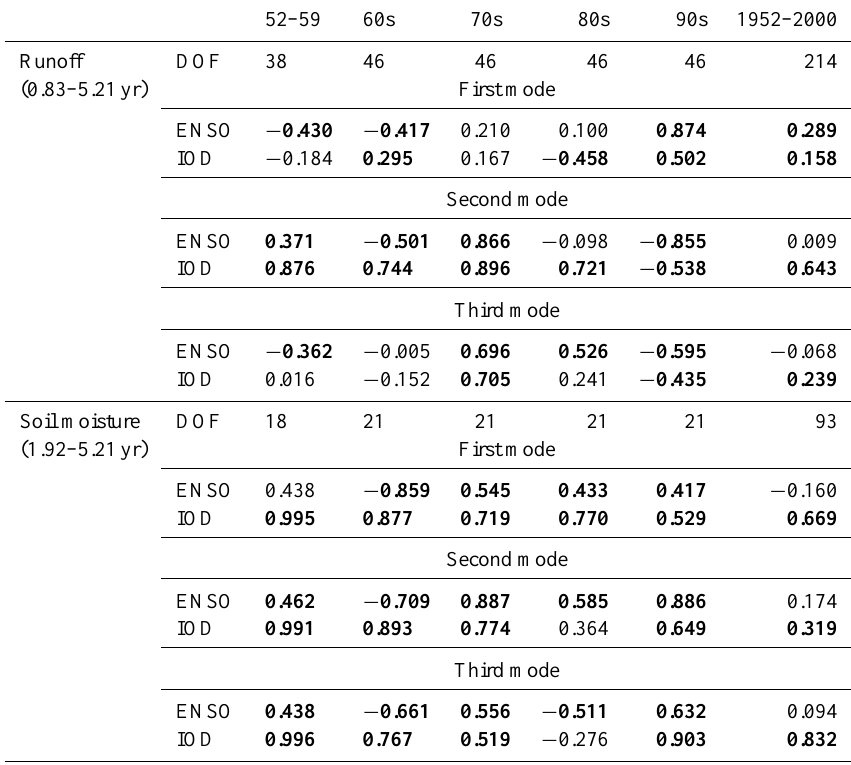
Table 3. Spearman’s rank correlations between the wavelet powers of runoff/soil moisture and selected climate indices in the low-frequency dominant variability band. DOF denotes the degrees of freedom. Bold indicates greater than 95% confidence